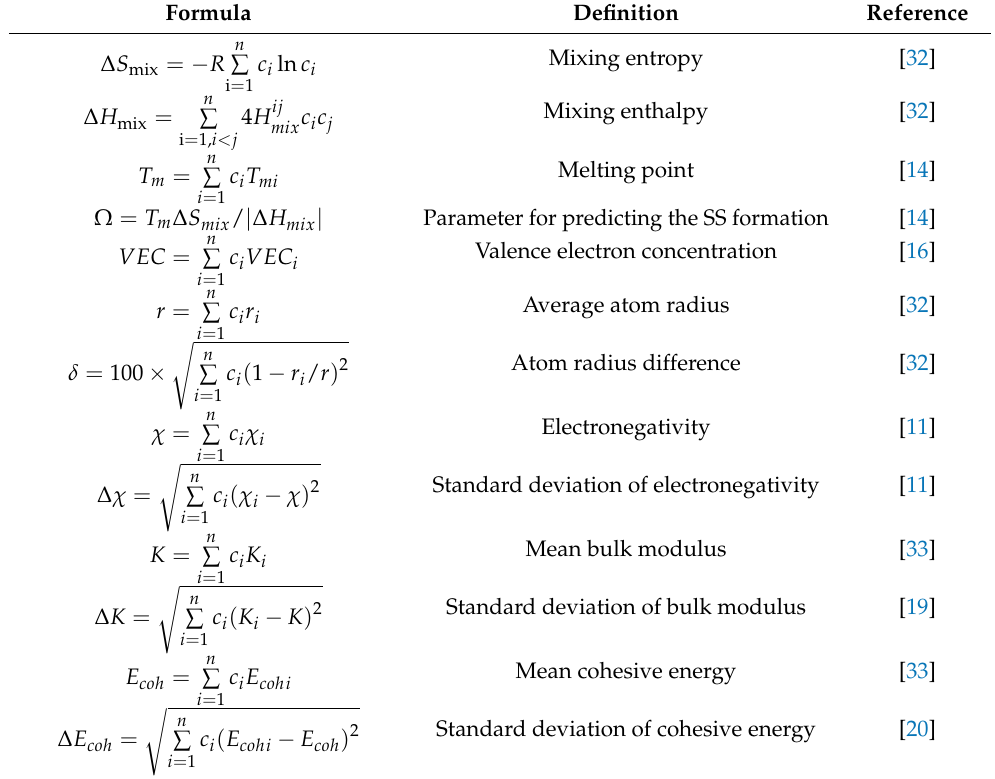
Table 1. Feature list of the phase prediction model of